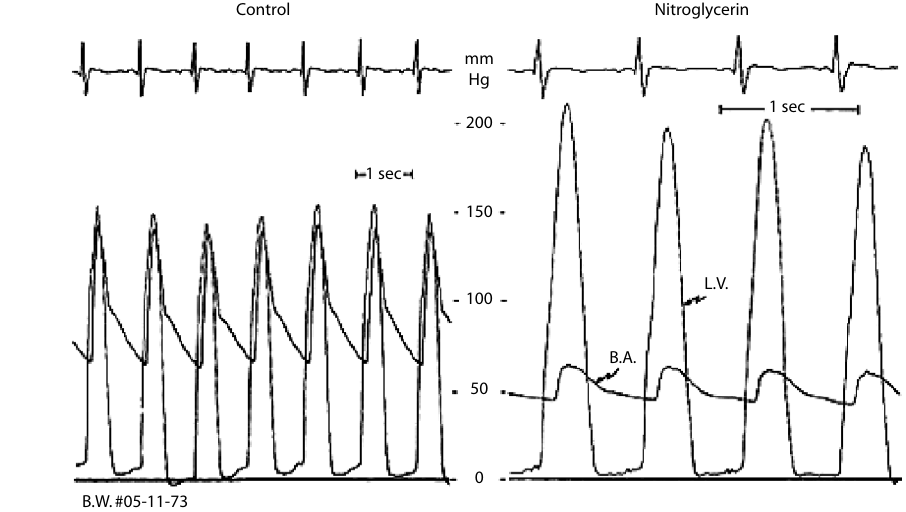
Figure 4. Circulatory response to nitroglycerin in patient B.W. with HCM. LV, left ventricular pressure pulse; BA, brachial arterial pressure pulse. (From Braunwald E, Oldham H N Jr, Ross J Jr, et al. The circulatory response of patients with idiopathic hypertrophic subaortic stenosis to nitroglycerin and to the Valsalva maneuver. Circulation 1964;29:422–431).